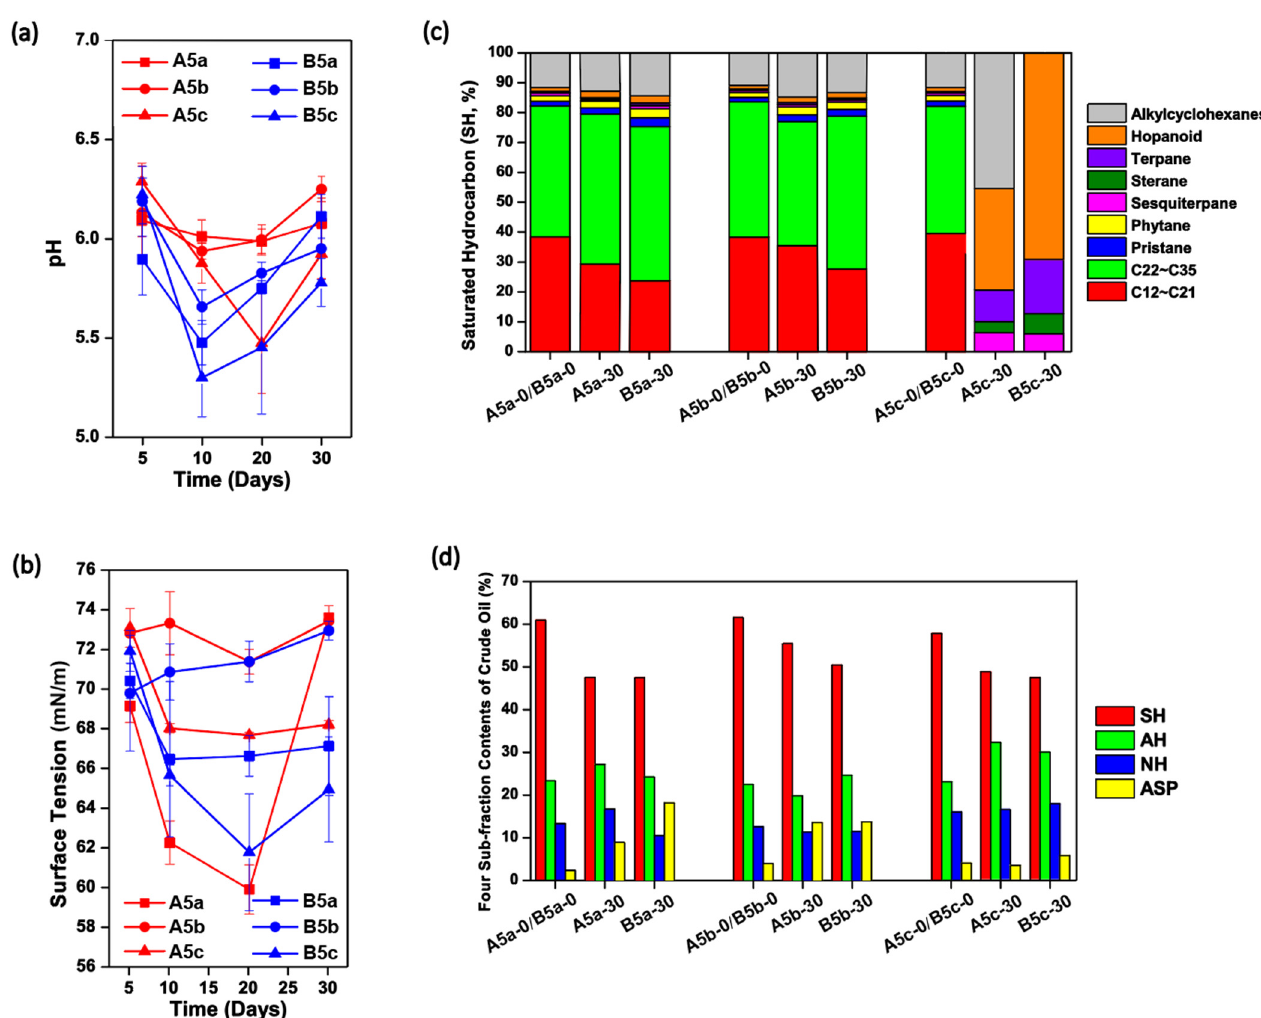
Figure 2. The effects of the exogenous bacterial strains Amycolicicoccus subflavus DQS3-9A1 T and Dietzia sp. DQ12-45-1b on physiochemical characteristics changes in cultures containing the thermally pretreated crude oil. The time courses of pH values ( a ) and surface tension degrees ( b ) in A. subflavus DQS3-9A1 T inoculated solutions containing one-time heated (A5a), twice heated (A5b), and raw (A5c) crude oil, and in Dietzia sp. DQ12-45-1b inoculated solutions containing one-time heated (B5a), double heated (B5b), and raw (B5c) crude oil; Histograms showing the saturated hydrocarbon components ( c ) and the four-subfraction contents ( d ) in the crude oil samples collected from Treatments A5a, A5b, A5c, B5a, B5b, and B5c at the beginning and end of the 30-day incubation. SH, saturated hydrocarbon; AH, aromatic hydrocarbon; NH, non-hydrocarbons; ASP,